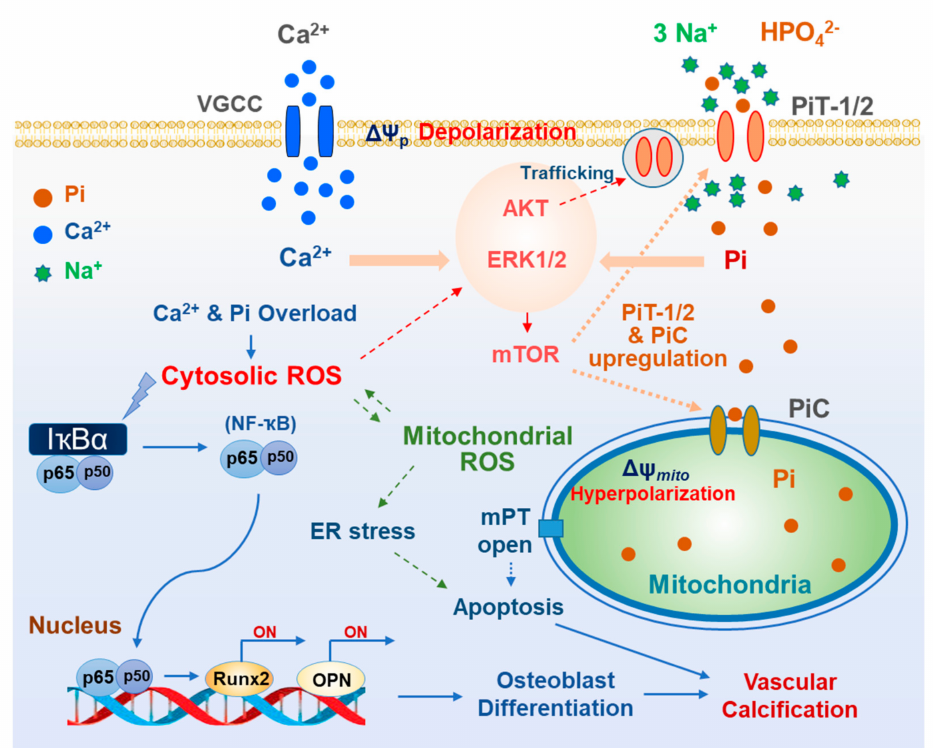
Figure 3. Oxidative stress related to plasmalemmal and mitochondrial Pi transporters in vascular calcification. Type III Na-Pi cotransporters, PiT-1 and PiT-2, can trigger plasma membrane depo- larization due to their electrogenic properties. This depolarization couples cytosolic Ca 2+ influx with Pi, leading to more Ca 2+ and Pi loading in cytosol. Suppressing the entrance of either Ca 2+ or Pi successfully attenuate oxidative stress. In addition, Pi influx activates ERK and AKT signaling further augment PiT-1/-2 abundance either by translational regulation or by surface